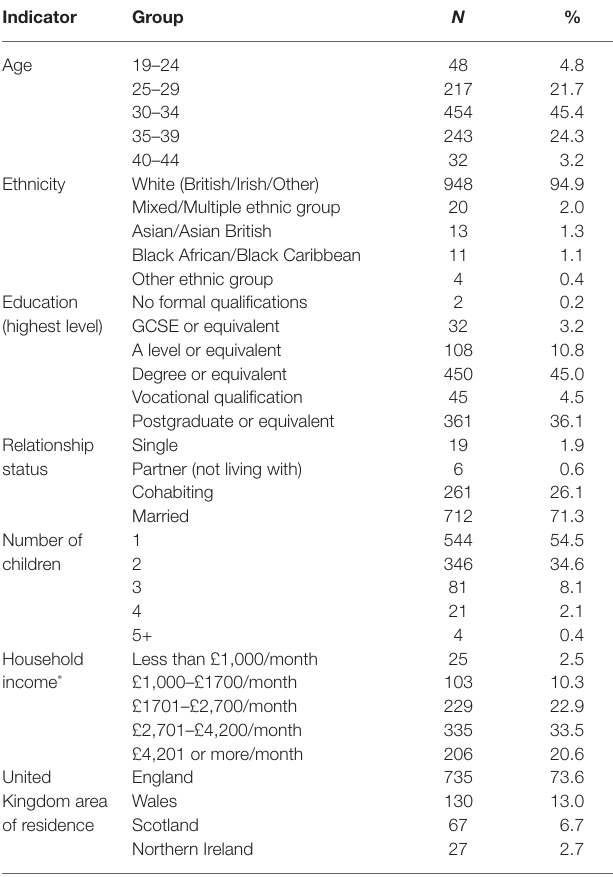
TABLE 2 | Maternal demographic